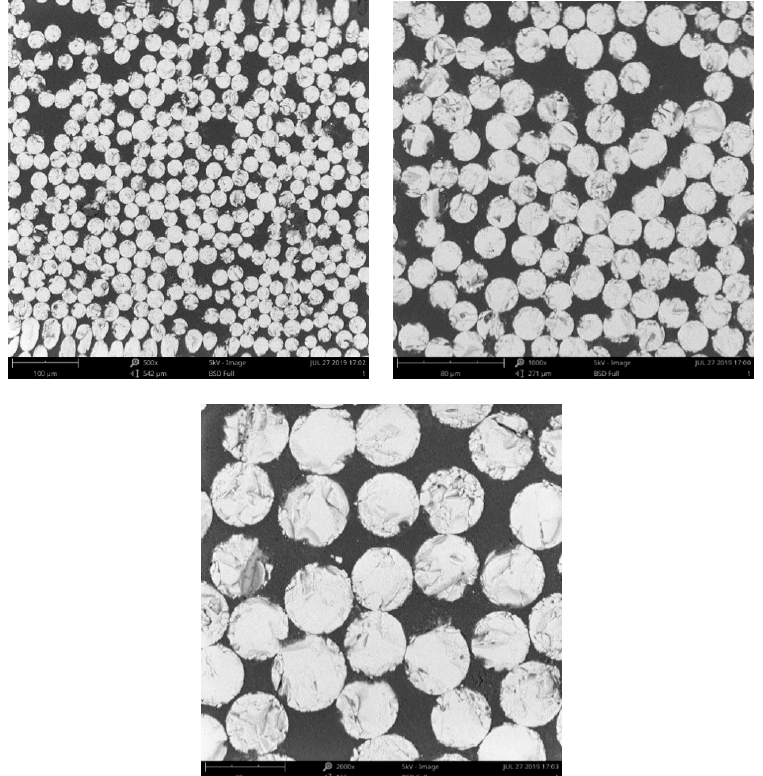
Figure 10. SEM images of the cross sections of the unconditioned GFRP bars.